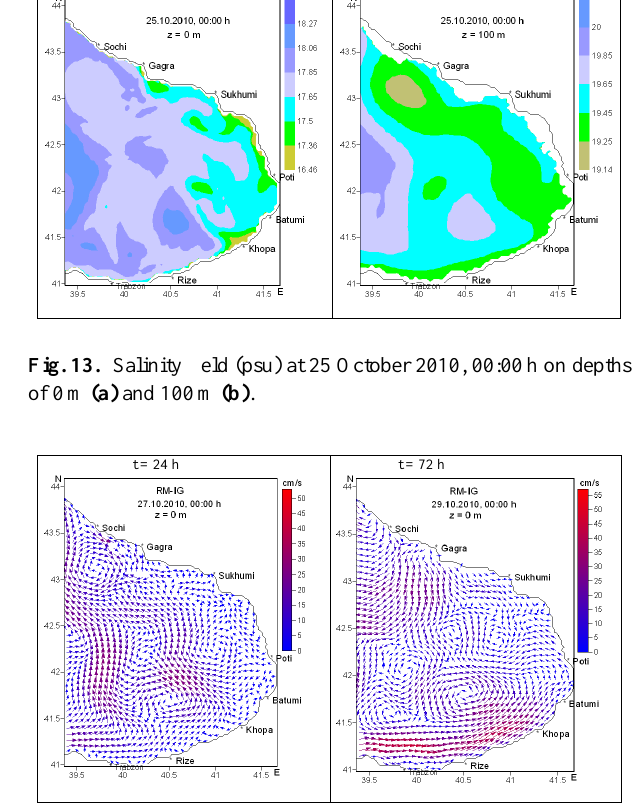
Fig. 14. The surface current fields predicted by RM-IG at 24 h (a) and 72 h (b) (the forecasting period is 26.10.2010, 00:00 h – 29.10.2010, 00:00 h).